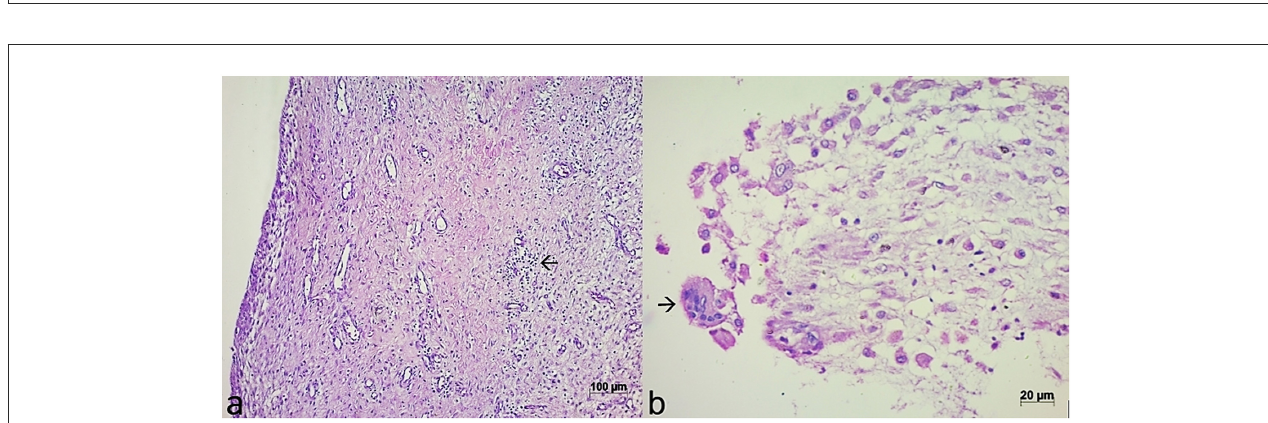
FIGURE5 Microscopic appearance of the induced membrane in a chicken with bone cement on day 21 postoperative. (a) Note the dense proliferation of fibrous connective tissue, highly vascularized and with mononuclear inflammatory infiltrate (arrow). HE, 20x. (b) Microscopic appearance of the induced membrane in a chicken with cefazolin powder-loaded bone cement on day 21 postoperative. Observe inflammatory infiltrate composed mainly of mononuclear inflammatory cells and multinucleated cells (arrow). HE,